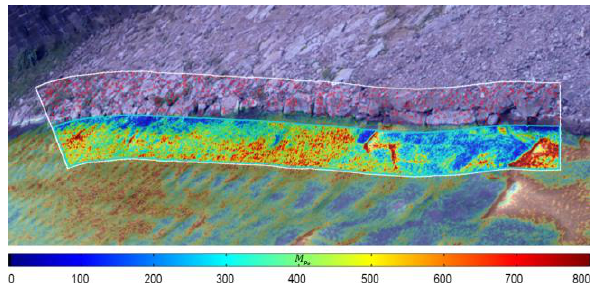
Figure 7. Spatio-temporal texture overlay referring to study region (II). White polygon: ROI from coarse water line preselection, Blue polygon: Initial water body pointing to dynamic image content; Red dots: Potential seed